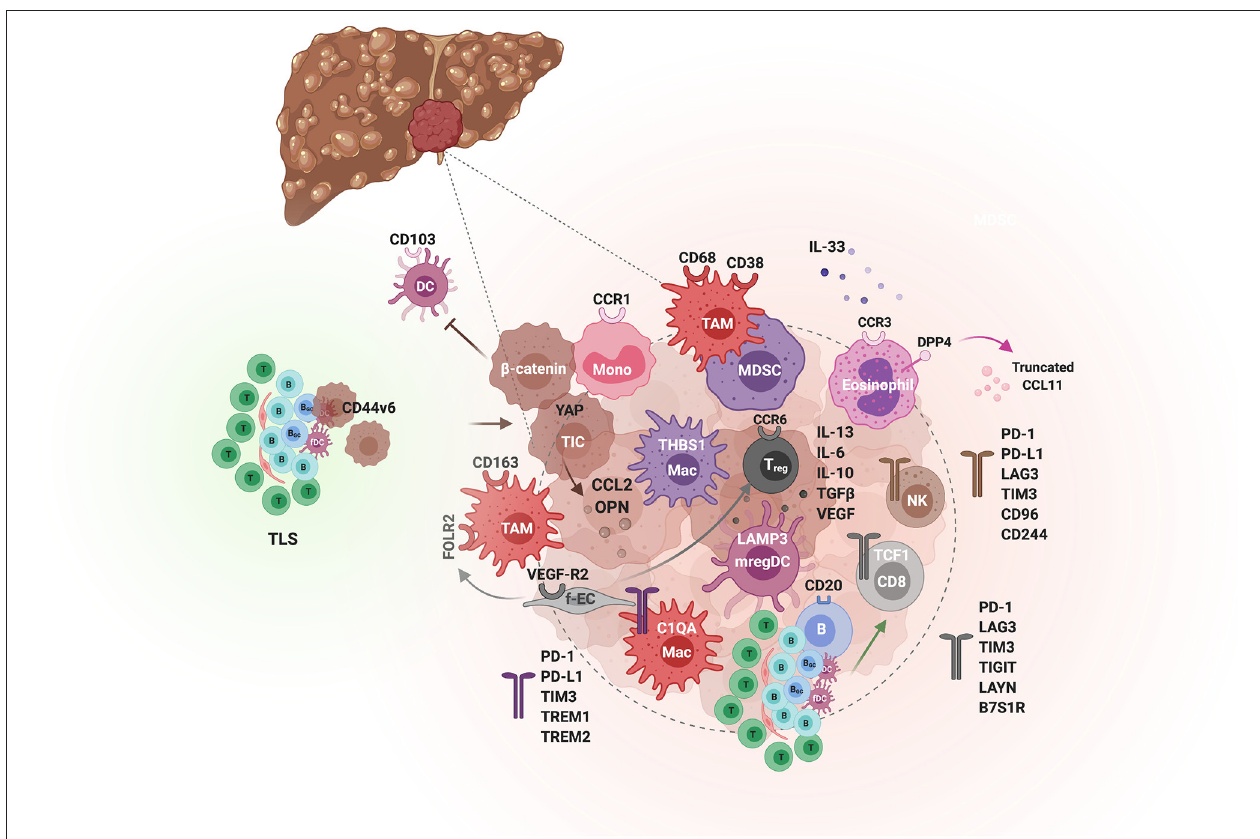
FIGURE 5 | The tumor immunological microenvironment of HCC. Schematic illustration of the different actors demonstrated to contribute to immunosuppression or immune activity in the TME of HCC. Tumor-initiating cells (TIC) and tumor cells (hues of brown) orchestrate the immunological environment by secreting inflammatory cytokines e.g., osteopontin (OPN) and chemokines e.g., the monocyte chemoattractant CCL2, which promote tumorigenesis through the recruitment of monocytes and their differentiation to tumor-associated macrophages (TAMs). In addition, β -catenin-activated tumor cells can inhibit anti-tumor immunity by blocking CD103 + DCs tumor infiltration. Spatially, TAMs are enriched in the peri-tumoral area, express CD68, CD163, CD38, and the folate receptor (FOLR2), induced by fetal-associated endothelial cells (fEC). Two subsets of tumor-enriched macrophages can be distinguished by single cell analyses, THBS1 + macrophages and C1QA + macrophages, with an MDSC and TAM signature, respectively. The latter is associated with a poor prognosis in HCC. The immunosuppressive activity of TAMs is mediated by various immune checkpoints, including PD-1, PD-L1, TIM-3, TREM1 and TREM2. Besides TAMs, the TME is enriched in Treg but depleted of other T cells and NK cells, which when present exhibit an exhausted phenotype. Among the CD8T cells, The PD-1 + TCF1 + “precursors” are associated with a good response to anti-PD-1. TLS found in the adjacent non-tumoral liver tissue are associated with a poor prognosis as they can harbor progenitor/cancer stem cells (expressing CD44v6) and promote tumorigenesis by impairing the clearance of senescent hepatocytes. In contrast, intratumoral TLS and CD20 + B cells are predictive of a lower risk of relapse and a better CD8T cell anti-tumor activity. Eosinophils also confer a tumorilytic activity, and enhancing their recruitment with inhibitors of the CCL11 peptidase DPP4 improved the efficacy of anti-PD-1 + anti-CTLA4